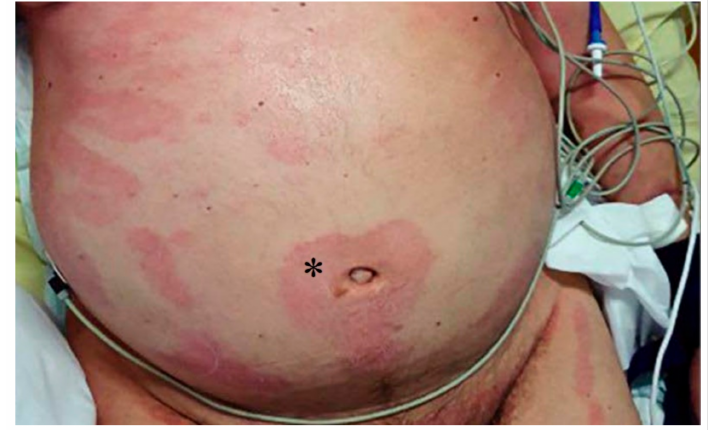
Figure 9. Papule-squamous eruption. * Papule-squamous eruption in abdomen. Sanchez J. et al. (2020)